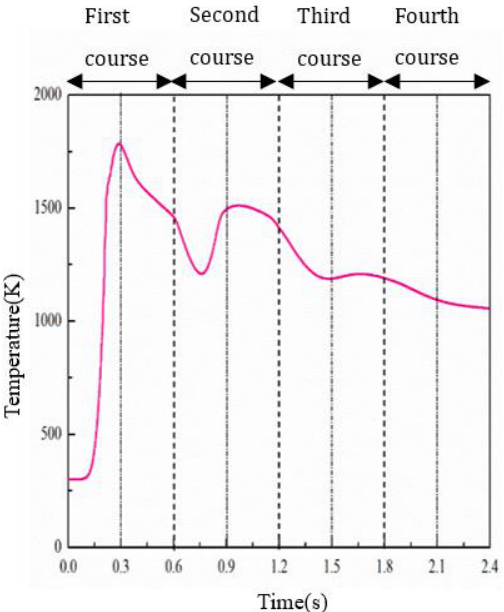
Figure 20. Temperature variation curve with time at the location of the observation point.